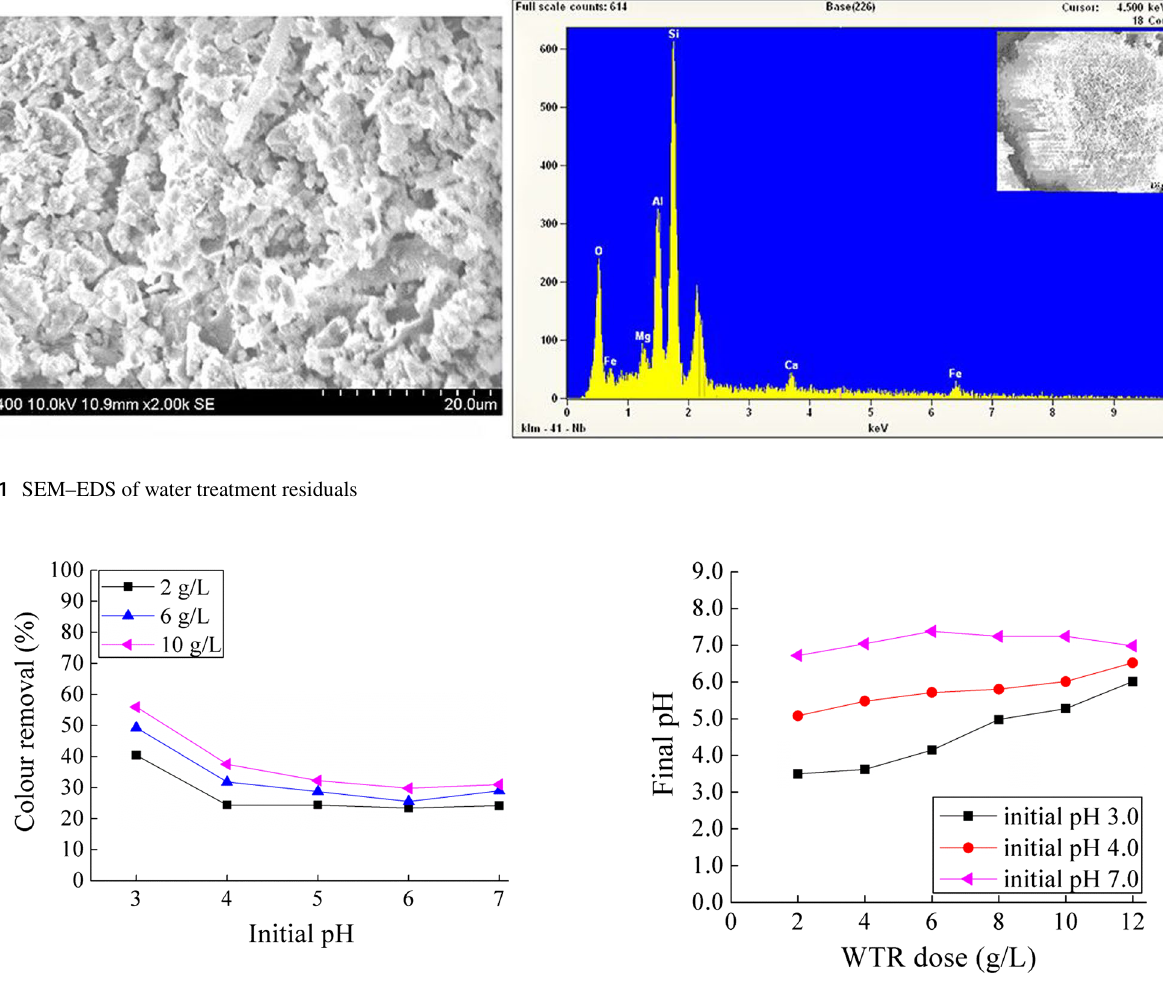
Fig. 2 Effect of initial pH on colour removal at different WTR dos- ages Fig. 3 Effect of WTR dose on final pH at different initial pH